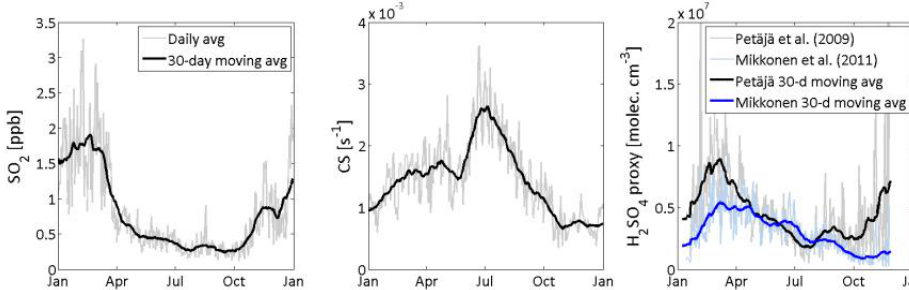
Fig. 4. The seasonal pattern of SO 2 , CS and H 2 SO 4 proxy, average of years 1992–2011.